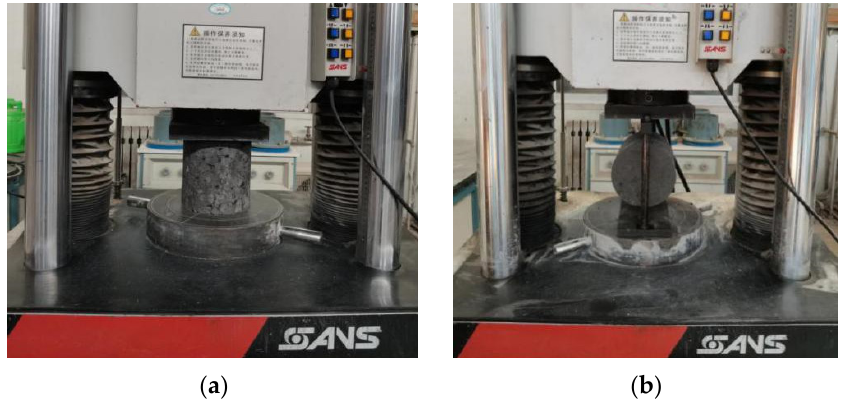
Figure 5. ( a ) Unconfined compressive strength test and ( b ) splitting strength test.